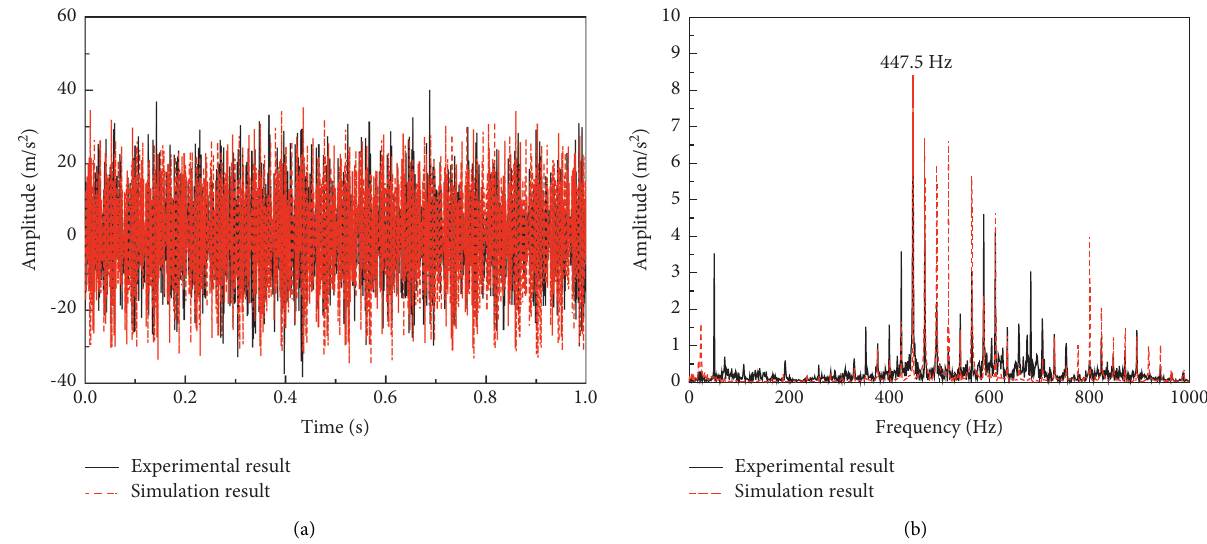
Figure 4: Validation of the vehicle-track model by comparison with experimental test: lateral acceleration of the axle-box in time domain (a) and frequency domain